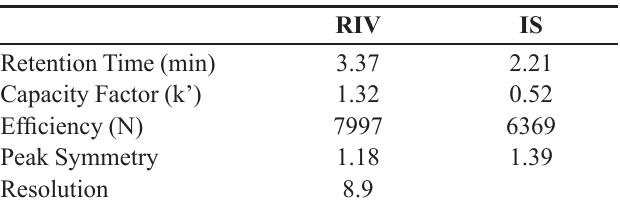
TABLE II - System suitability parameters for the proposed